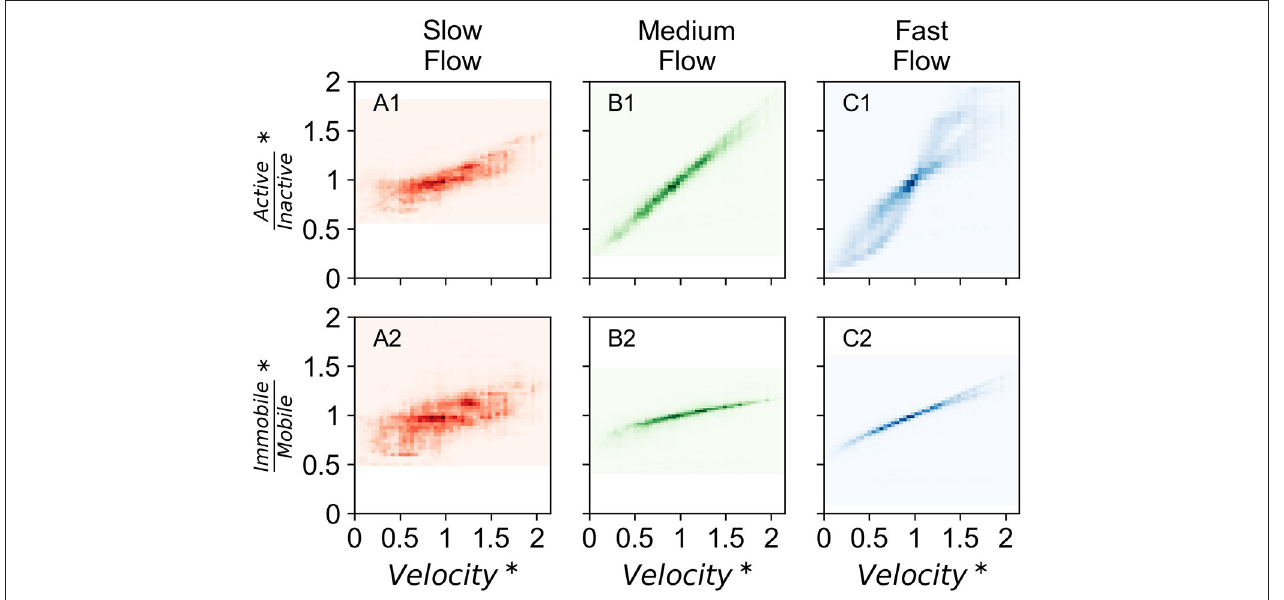
FIGURE 4 | Density plot of contribution of microbial subpopulations in all investigated domains normalized by that in steady state conditions with normalized velocity in corresponding domain (velocity normalized by that in steady state conditions) over the entire simulation period of 15 years for the three investigated time series (T1, T2, and T5). Darker colors indicate higher density of points. (A1) Displays ratio of active and inactive biomass and (A2) displays ratio of immobile and mobile biomass in the slow flow regime. (B1) Displays ratio of active and inactive biomass and (B2) displays ratio of immobile and mobile biomass in the medium flow regime. (C1) Displays ratio of active and inactive biomass and (C2) displays ratio of immobile and mobile biomass in the fast flow regime. *Data points are normalized by that in steady state